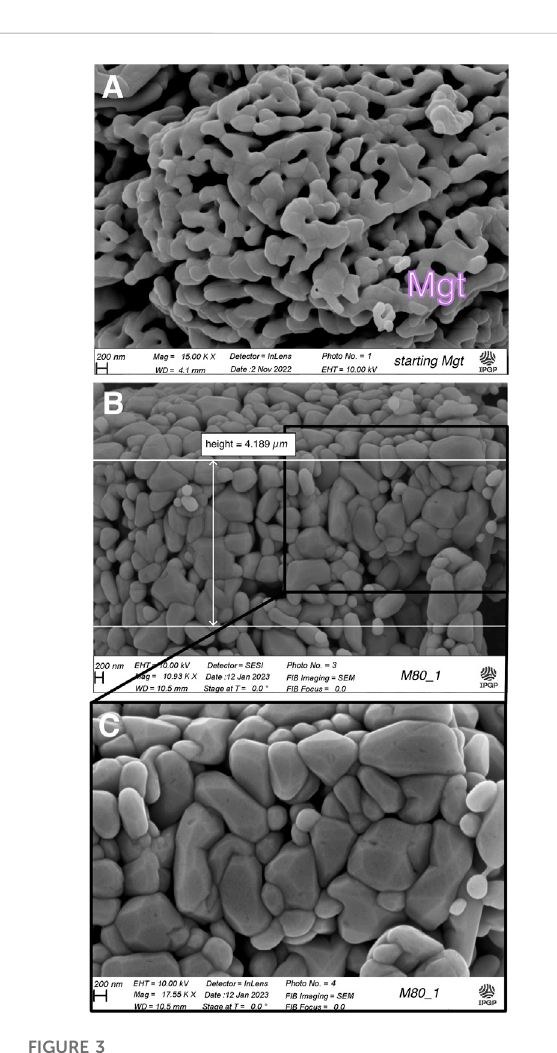
FIGURE 3 SEM images of (A) the starting magnetite compared to (B) magnetite after alteration at 80 ° C from M80_1 capsule. Note the higher mineral density and better crystallization after alteration. Mgt refers to magnetite. (C) Zoom of an altered magnetite surface from (B) , highlighting mineral sharp edges. FIGURE 4